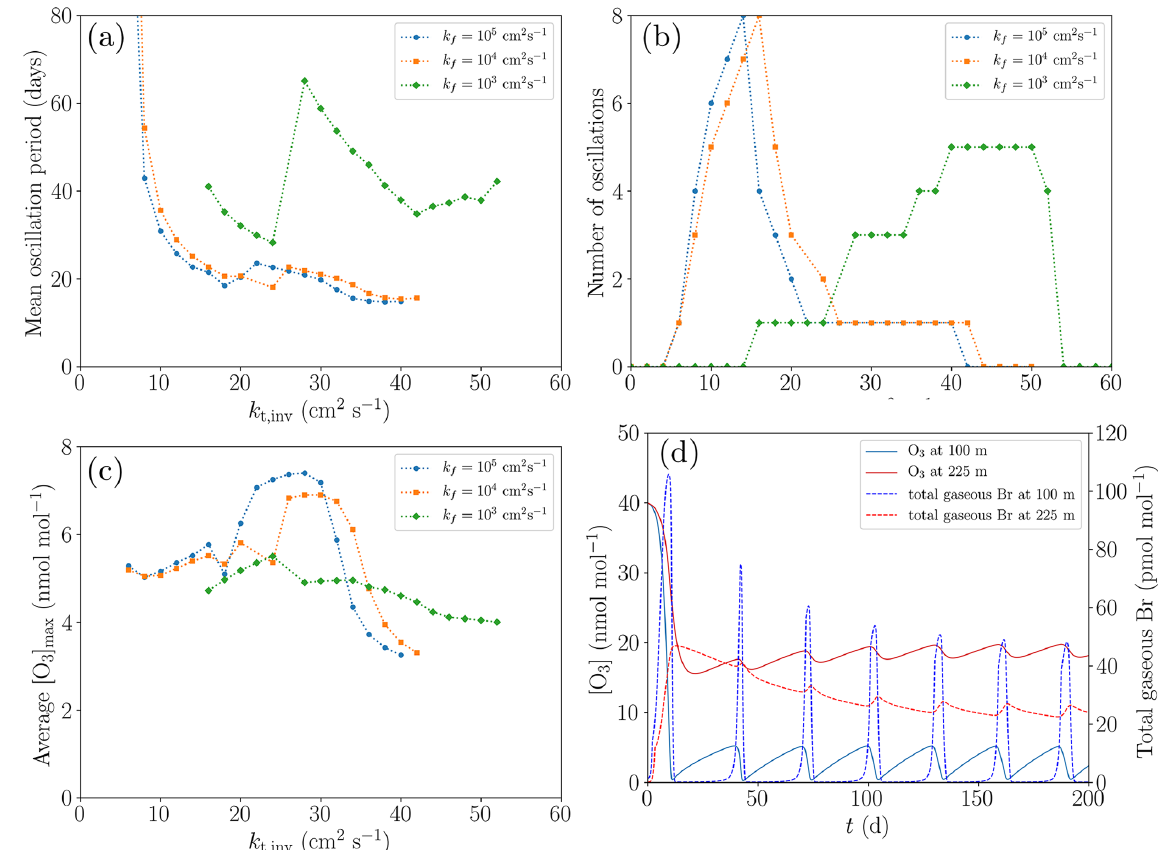
Figure 10. Dependence of the oscillation characteristics on the variations of k t , inv and k f (a–c) , and the variation of the mixing ratios of O 3 and Br at two different heights (100 and 225m) for the base settings (d) . (a) Average oscillation period during 200d. (b) Number of oscillations during 200d. (c) Average maximum mixing ratio of ozone. (d) Profiles of the mixing ratios of O 3 and total gaseous